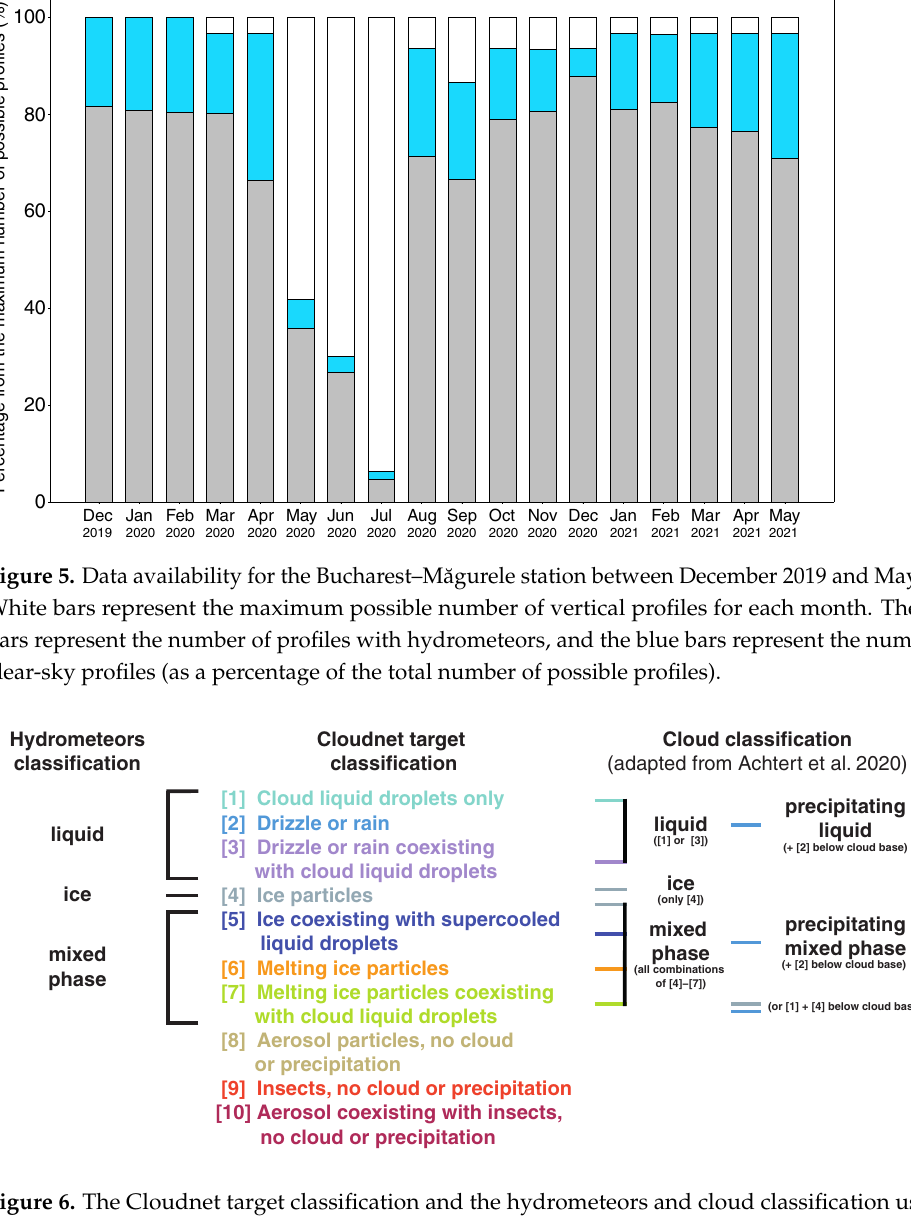
Figure 6. The Cloudnet target classification and the hydrometeors and cloud classification used in this study. The cloud classification is adapted from